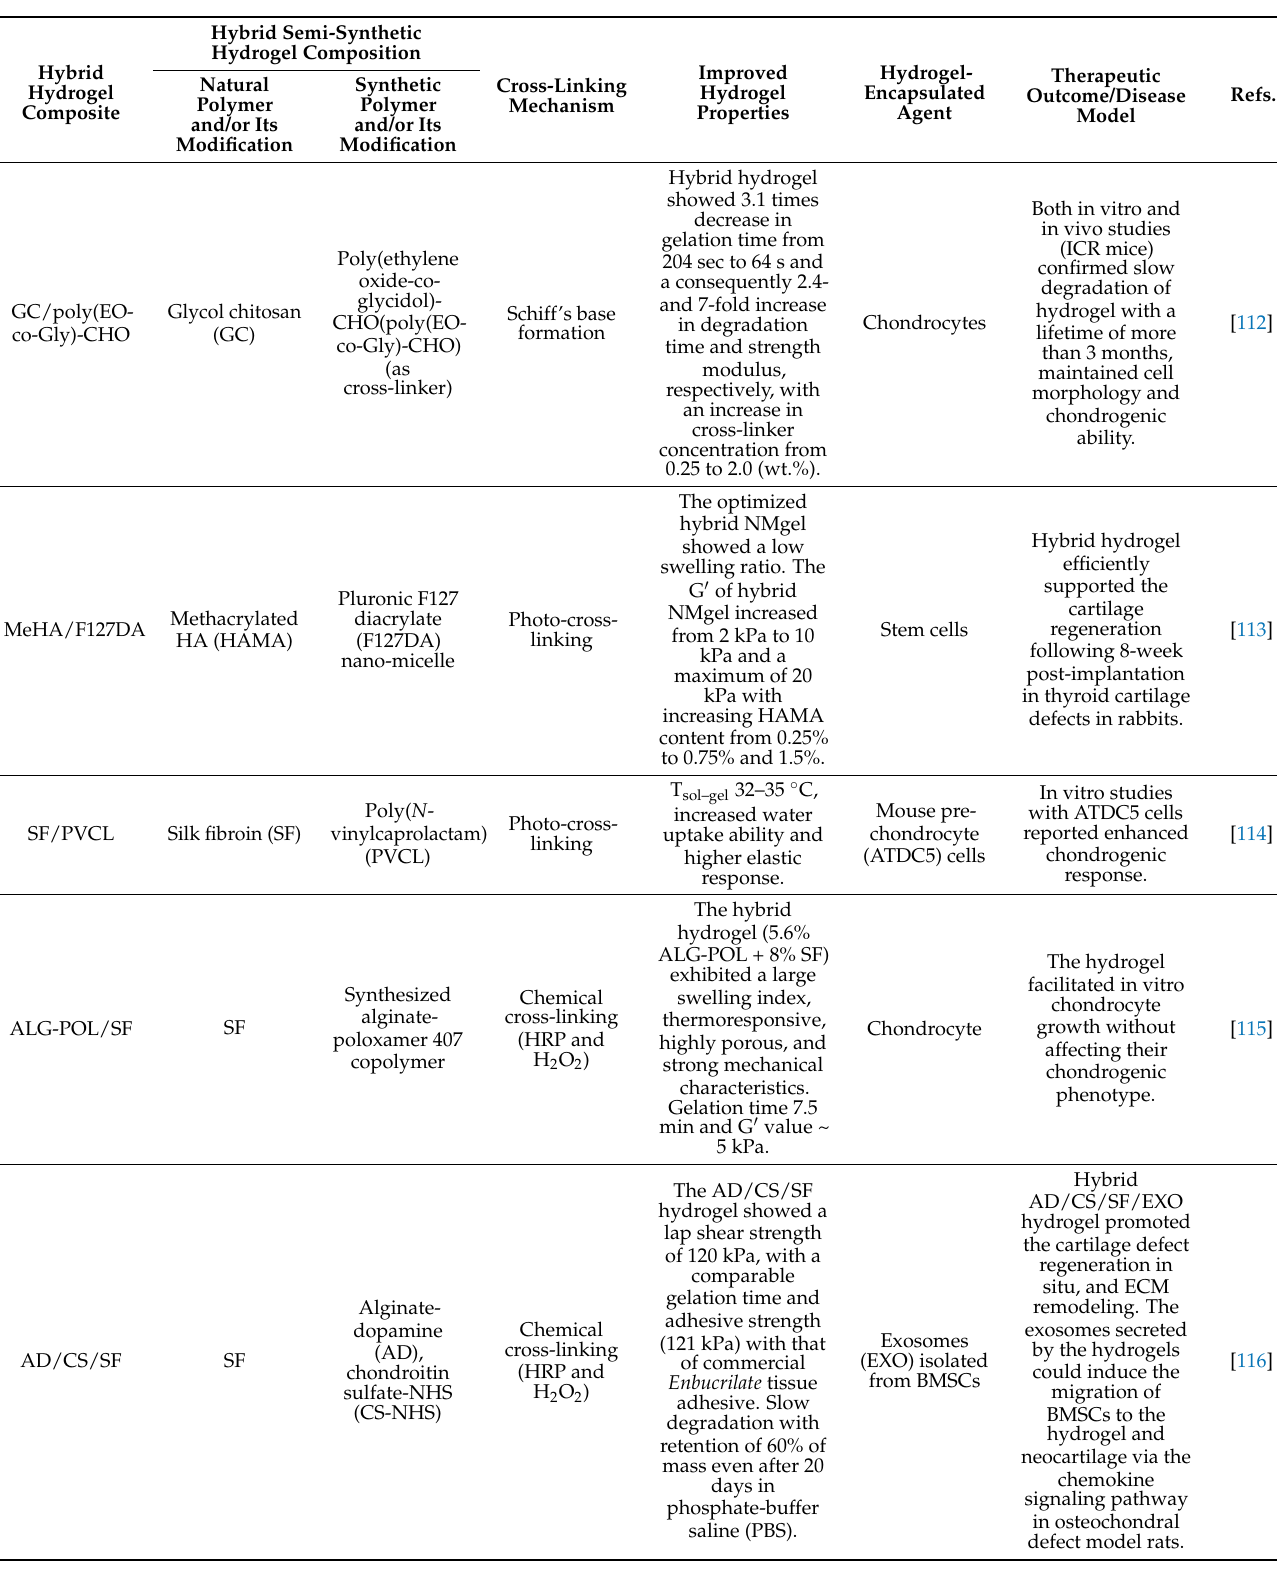
Table 1. Semi-synthetic hydrogel composites encapsulating cells and small molecule drugs for arthritis